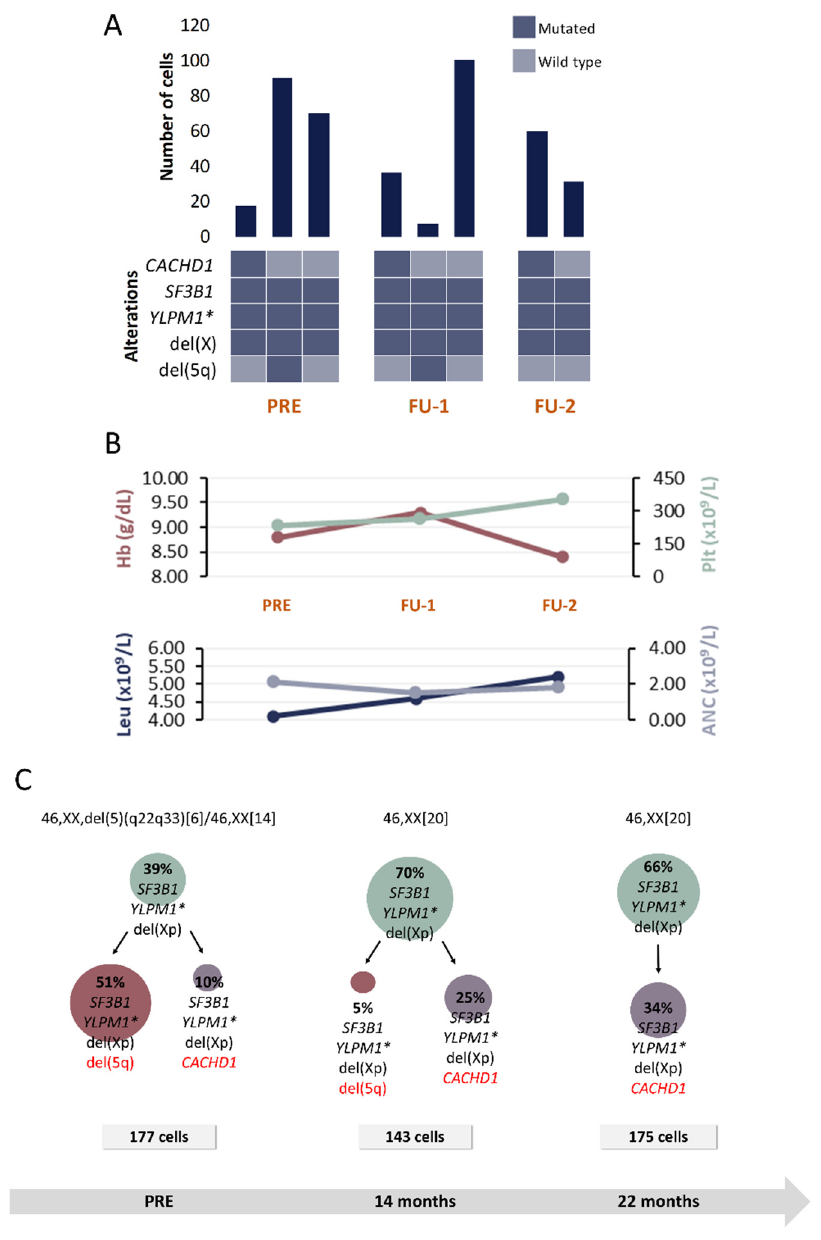
Figure 3. Clinical and molecular characteristics of patient P2. ( A ) Bar plot depicts the number of cells with a given genotype for each clone that was detected at the moment of pre-treatment (PRE), 1st follow-up (FU-1) and 2nd follow-up (FU-2). Heatmap below the bars indicates the genotype for each clone: dark blue and light blue are used to indicate the mutated or wild-type state, respectively. ( B ) Hematological characteristics such as hemoglobin (Hb), platelet count (Plt), leukocyte count (Leu) and absolute neutrophil count (ANC) are indicated for each analyzed time point. ( C ) Proposed clonal architecture, karyotype and number of analyzed cells for each time point is indicated. Color red distinguishes new acquired alterations in each clone. * homozygous mutation.